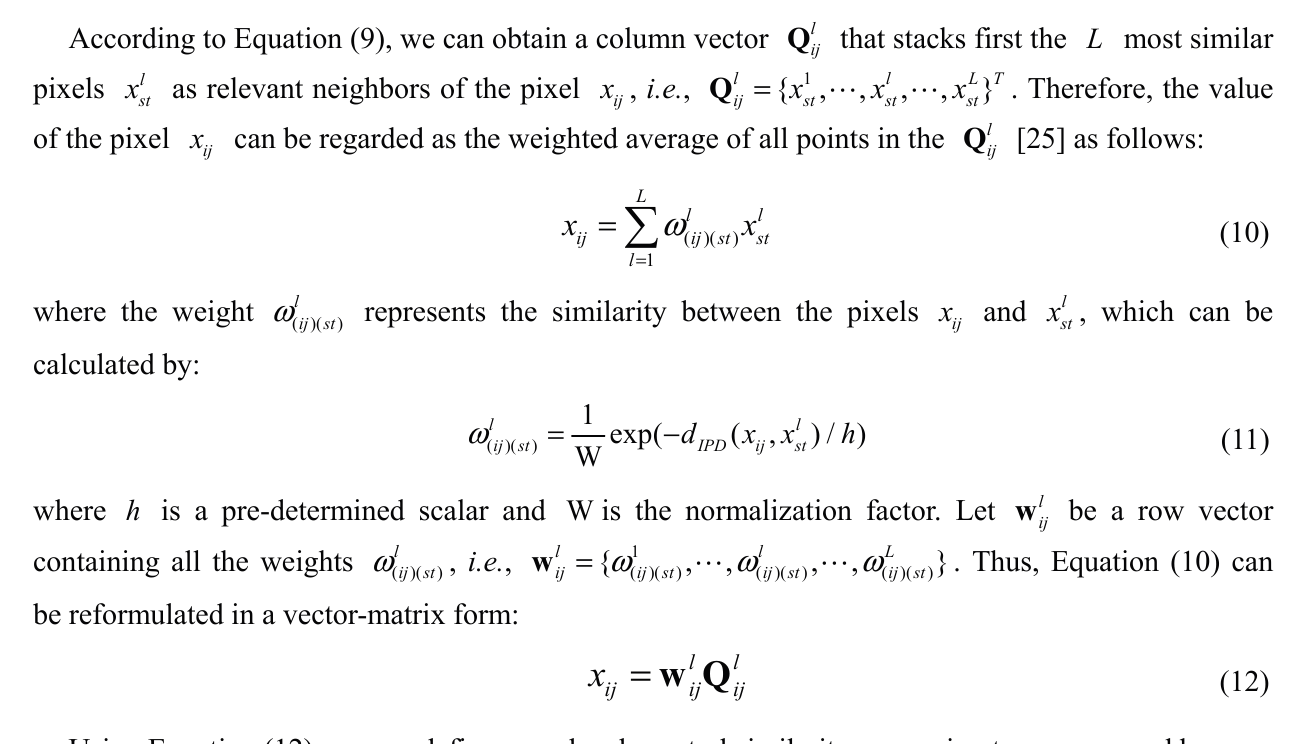
Figure 3. Flowchart of concrete process of calculating IPD with the 3 × 3 spatial